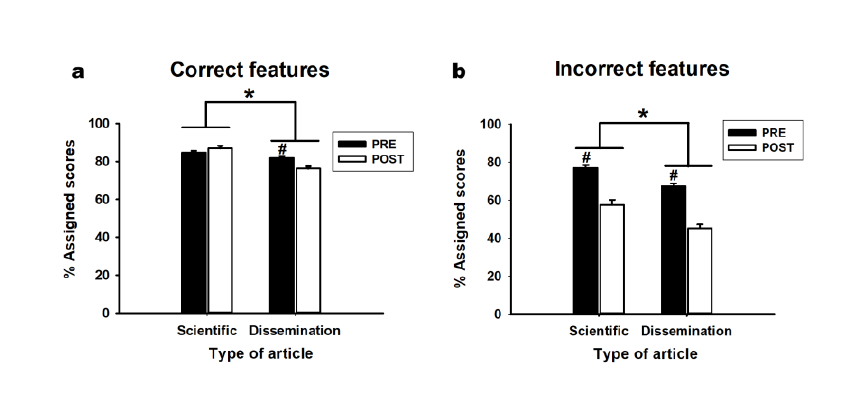
Figure 4. Percentage of scores classified as correct and incorrect given by the students to each type of article in the pre and post-intervention (Mean ± S.E.M). The x- axis shows the two types of articles: scientific and dissemination articles. a. Percentage of scores given to the correct features of each article. Comparing pre- and post- intervention, there were differences between the two types of articles (* p <0.05). Correct scores for the dissemination articles were lower in the post-intervention than in the pre-intervention (# p <0.001). b. Percentage of scores given to the incorrect features of each article. There were differences between the two types of articles in the pre-intervention and the post-intervention measure (* p <0.05). Comparisons between pre and post-intervention measures revealed lower percentage of incorrect scores given by the students for scientific and dissemination articles (# p